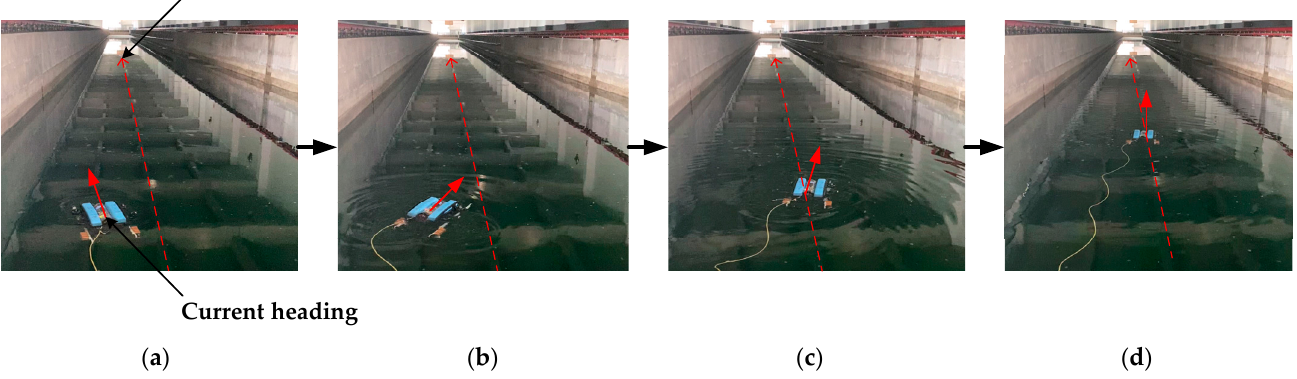
Figure 14. Process of UUV heading change in heading planning experiment: ( a ) UUV starts from the starting position; ( b ) UUV starts to deviate from the target heading; ( c ) UUV approaches the target heading; and ( d ) UUV steadily advances on the target heading.